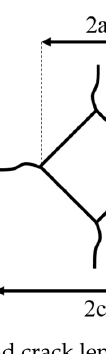
Figure 3. Diagonal and crack lengths of a Vickers indentation.